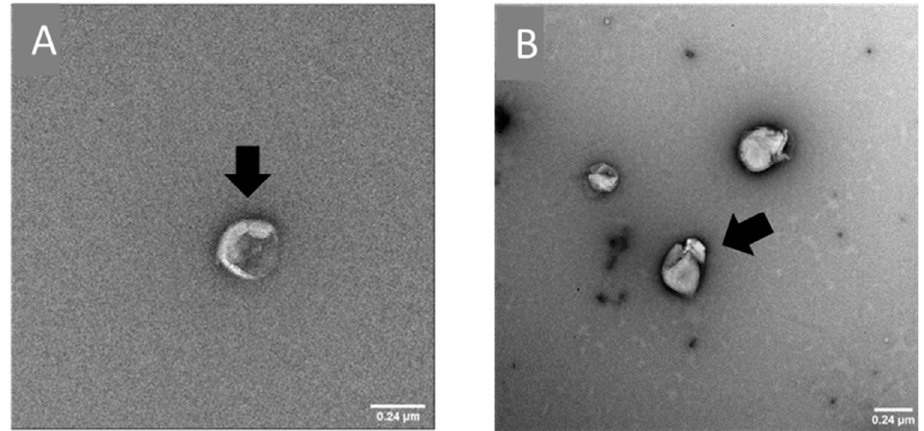
Figure 2. TEM images of blank DOTAP4 liposomes manufactured by thin-film layer rehydration ( A ), and by microfluidics ( B ). Bar = 0.24 µm.